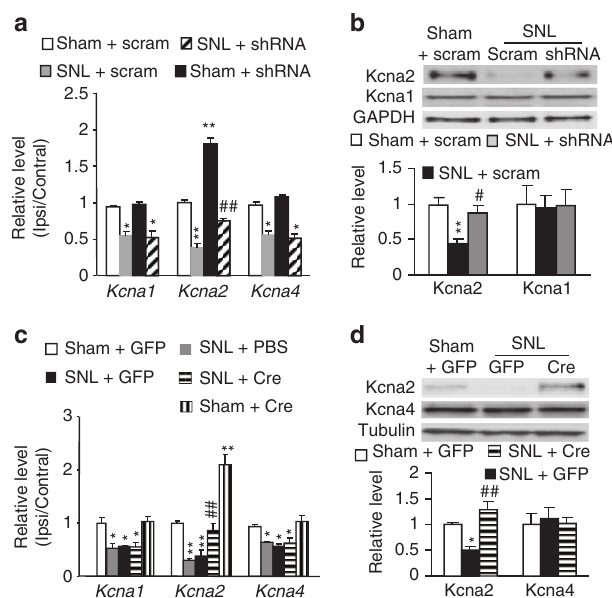
Figure 7 | Blocking DRG DNMT3a increase rescues Kcna2 expression in the injured DRG of rats or mice post-SNL. ( a , b ) Levels of Kcna1 , Kcna2 , and Kcna4 mRNAs in the ipsilateral (Ipsi) or contralateral (Contral) L5 DRG ( a ) and levels of Kcna1 and Kcna2 proteins in the ipsilateral L5 DRG ( b ) from the AAV5- Dnmt3a shRNA (shRNA)- or AAV5- Dnmt3a scrambled shRNA (scram)-injected rats on day 7 post-SNL or sham surgery. n ¼ 6 rats/group. One-way ANOVA followed by post hoc Tukey test, F group (3, 15) ¼ 18.9 for Kcna1 mRNA, F group (3, 15) ¼ 128.6 for Kcna2 mRNA, F group (3, 15) ¼ 38.9 for Kcna4 mRNA, F group (2, 8) ¼ 0.02 for Kcna1 protein, and F group (2, 8) ¼ 12.2 for Kcna2 protein. * P o 0.05 or ** P o 0.01 versus the corresponding sham plus scram group. # P o 0.05 or ## P o 0.01 versus the corresponding SNL plus scram group. Full-length blots are presented in Supplementary Fig. 6. ( c , d ) Levels of Kcna1 , Kcna2 and Kcna4 mRNAs in the ipsilateral (Ipsi) or contralateral (Contral) L4 DRG ( c ) and levels of Kcna2 and Kcna4 proteins in the ipsilateral L4 DRG ( d ) from the AAV5- Cre (Cre)- or AAV5- GFP (GFP)-injected Dnmt3a fl/fl mice on day 7 post-SNL or sham surgery. n ¼ 12 mice/group. One-way ANOVA followed by post hoc Tukey test, F group (4, 16) ¼ 9.68 for Kcna1 mRNA, F group (4, 16) ¼ 36.9 for Kcna2 mRNA, F group (4, 16) ¼ 6.40 for Kcna4 mRNA, F group (2, 8) ¼ 13.4 for Kcna2 protein, and F group (2, 8) ¼ 0.10 for Kcna4 protein. * P o 0.05 or ** P o 0.01 versus the corresponding sham plus GFP group. ## P o 0.01 versus the corresponding SNL plus GFP group. Full-length blots are presented in Supplementary Fig.